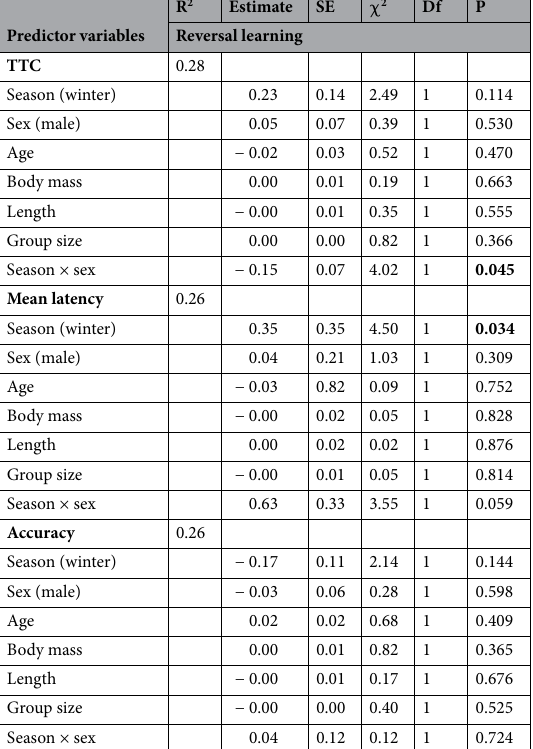
Table 3. Results from LMM and GLMM analysed for the influence season, sex, age, body mass, length and group size on the reversal learning performance, group ID is a random factor (bold values P < 0.05).